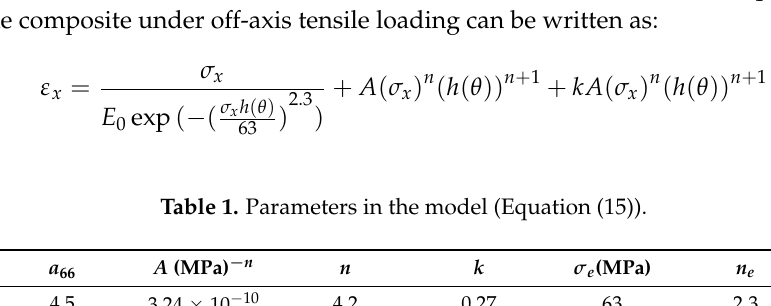
Figure 13. The relationship between the damage variable and the effective stress of a quasi-UD E- glass/polypropylene composite.